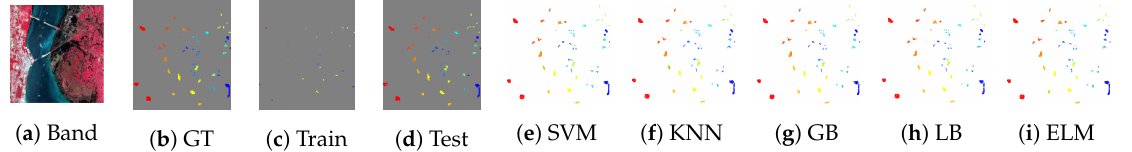
Figure 6. Salinas: ( a ) Ground Band, ( b ): True Ground Truths, ( c ): Training Ground Truths, ( d ): Test Ground Truths, and ground truths predicted by ( e ): SVM, ( f ): KNN, ( g ): GB, ( h ): LB, and ( i ): ELM classifier with 2% of selected training samples.